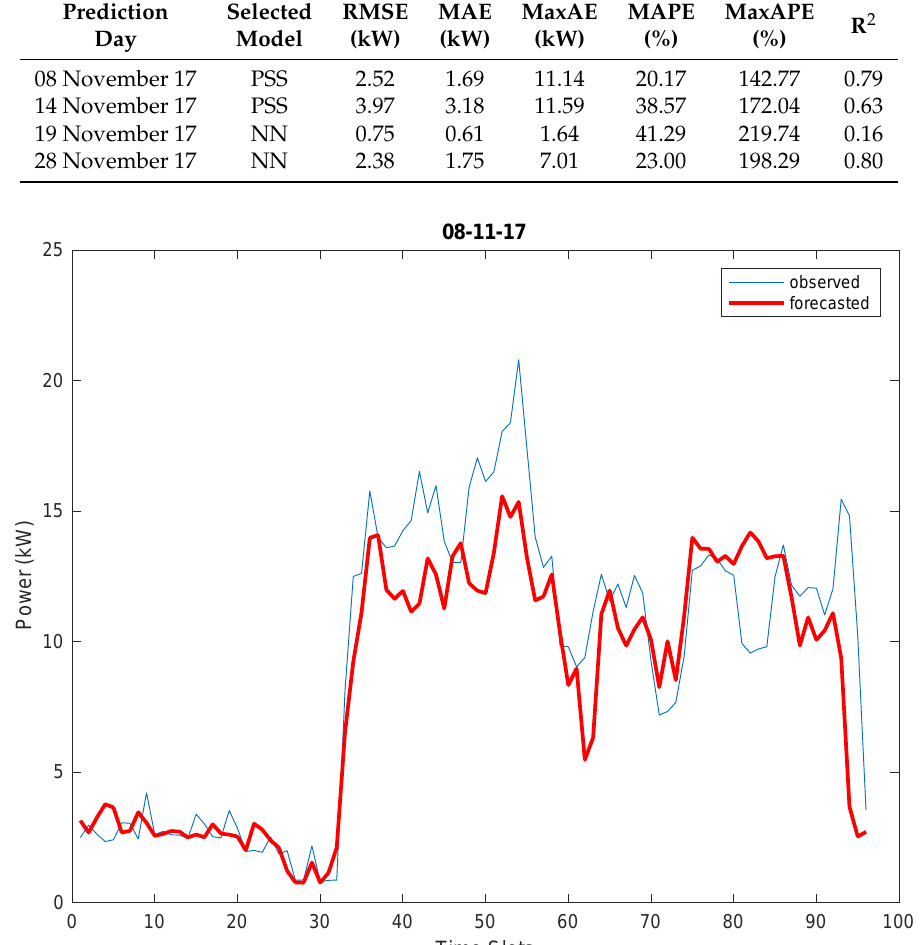
Figure 13. Pilot system: School (Palo del Colle), Day: 8 November 2017. Daily forecasts vs. observed power